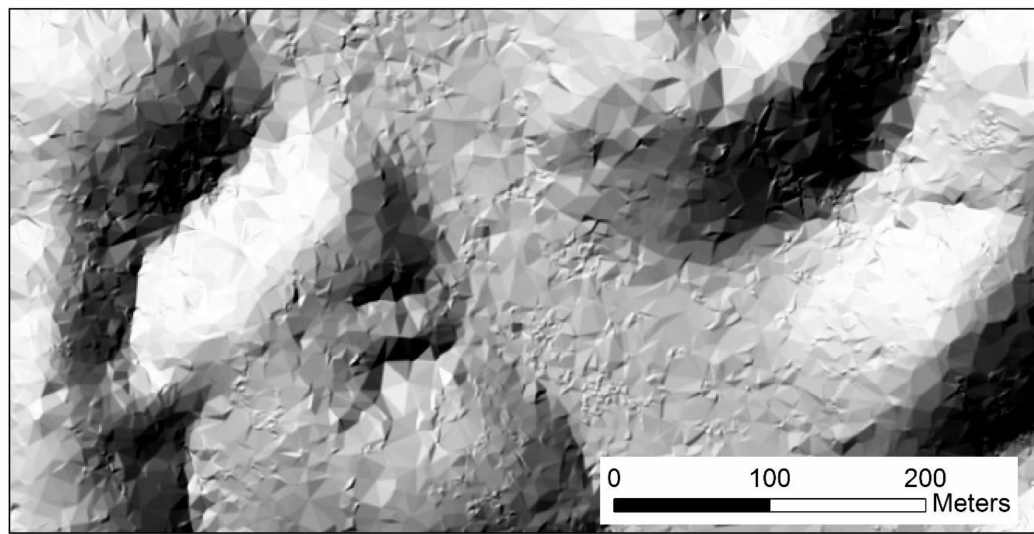
Figure 2. Hillshade of an extract of the lidar